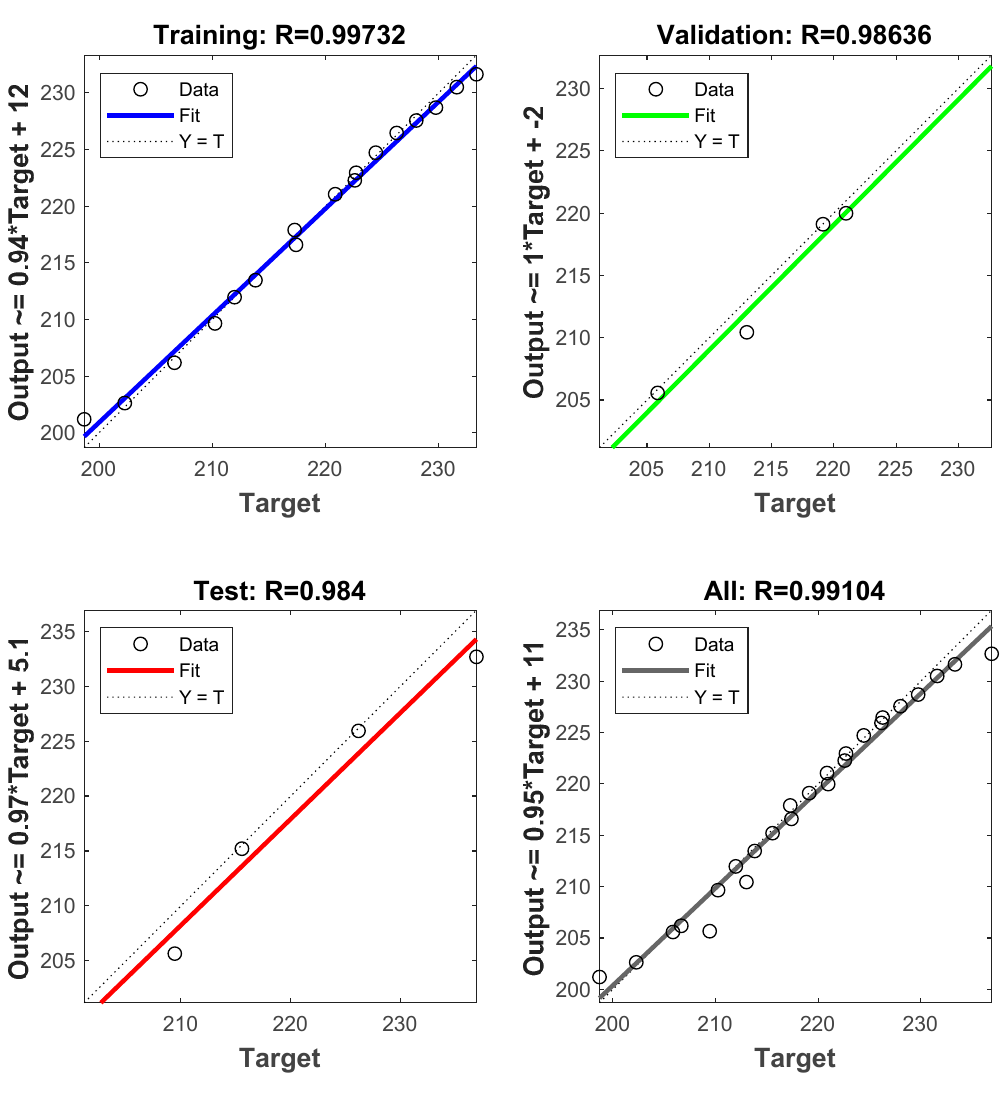
Figure 24. Optimal performance was found at 30 neurons in the hidden layer.